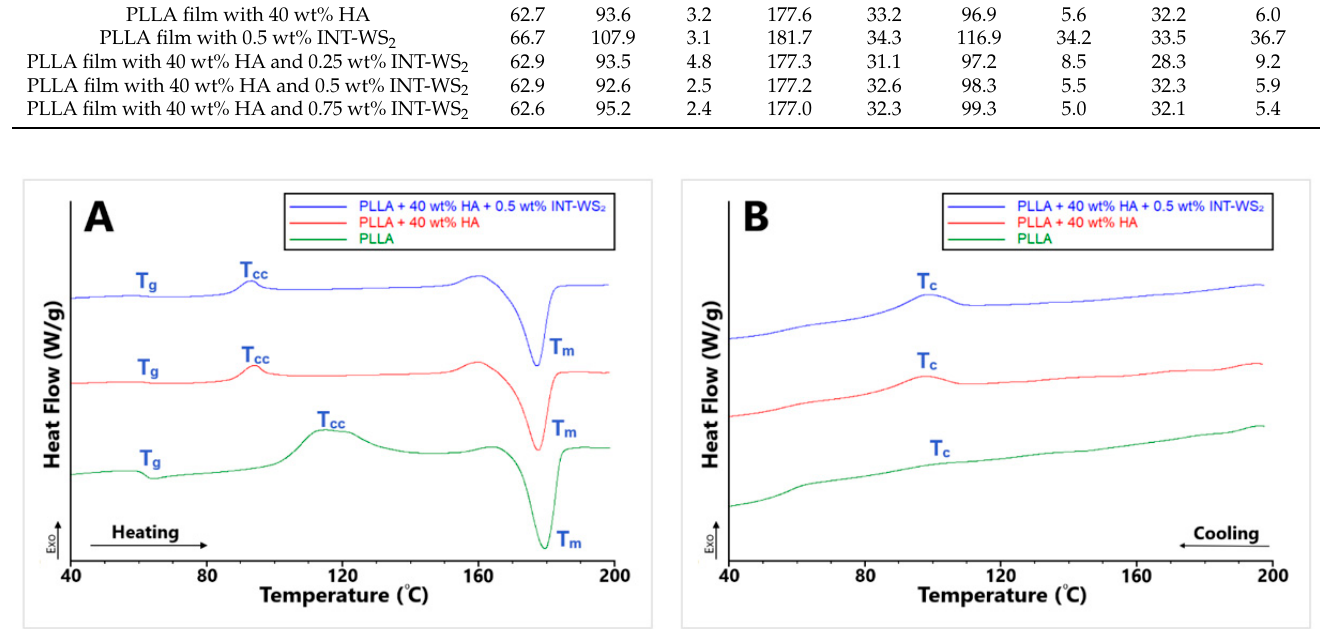
Figure 8. DSC thermograms of heating ( A ) and cooling ( B ) of PLLA film and HA/INT-WS 2 /PLLA nanocomposites.